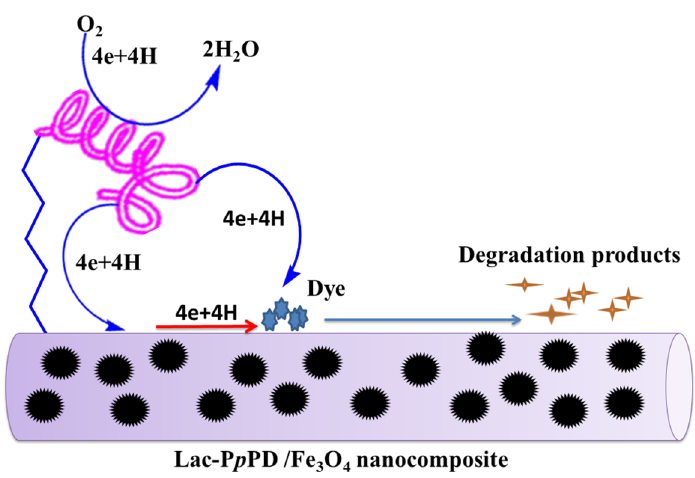
Figure 9. Proposed reaction scheme for dye removal catalyzed by Lac immobilized on P p PD/Fe 3 O 4 .